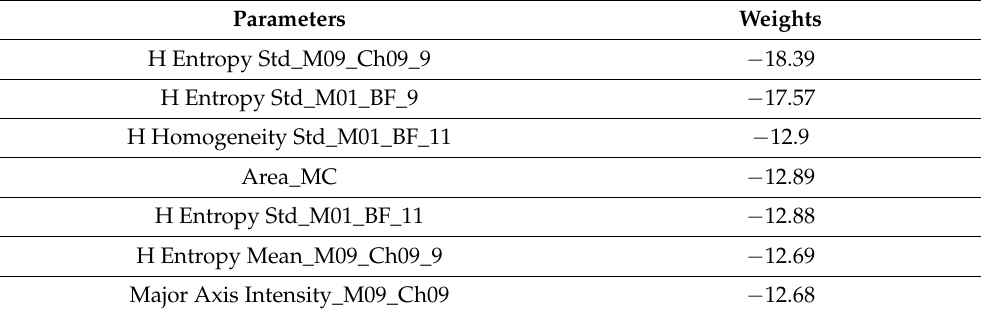
Figure 12. Gating strategy applied for the interpretation of the results of imaging flow cytometry (IFC) analysis. Analysis was assisted by an advanced tool to improve the interpretation of the cytometric results—the machine learning (ML) module of IDEAS software. “Batch” populations being representative images of microbial cells and debris (non-cellular objects and fragmented cells) were specified by the user to initiate a generation of the super feature (classifier) for the precise discrimination of single microbial cells vs. debris. Both classifiers were plotted into histograms, and events with values higher than zero belong to images that are best represented by their classifier. Table 3. Components of the cells_vs_debris classifier—parameters and weights indicating the dis- crimination efficiency.